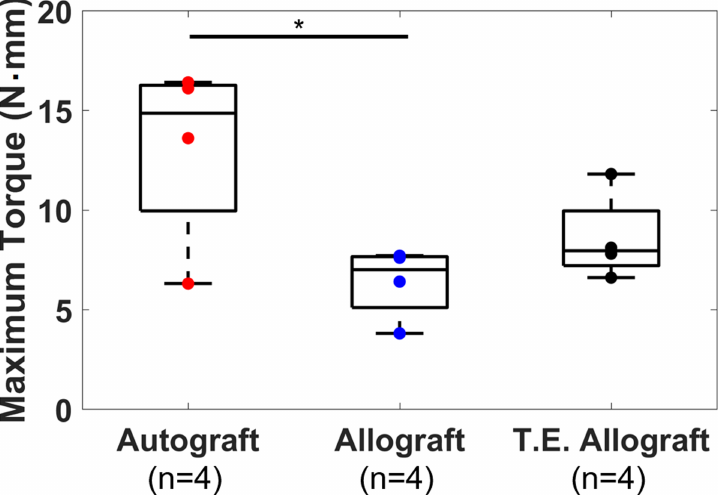
Fig 3. Maximum torque measured by biomechanical testing. (cid:3) indicates that the difference between autograft group and allograft group is statistically significant.